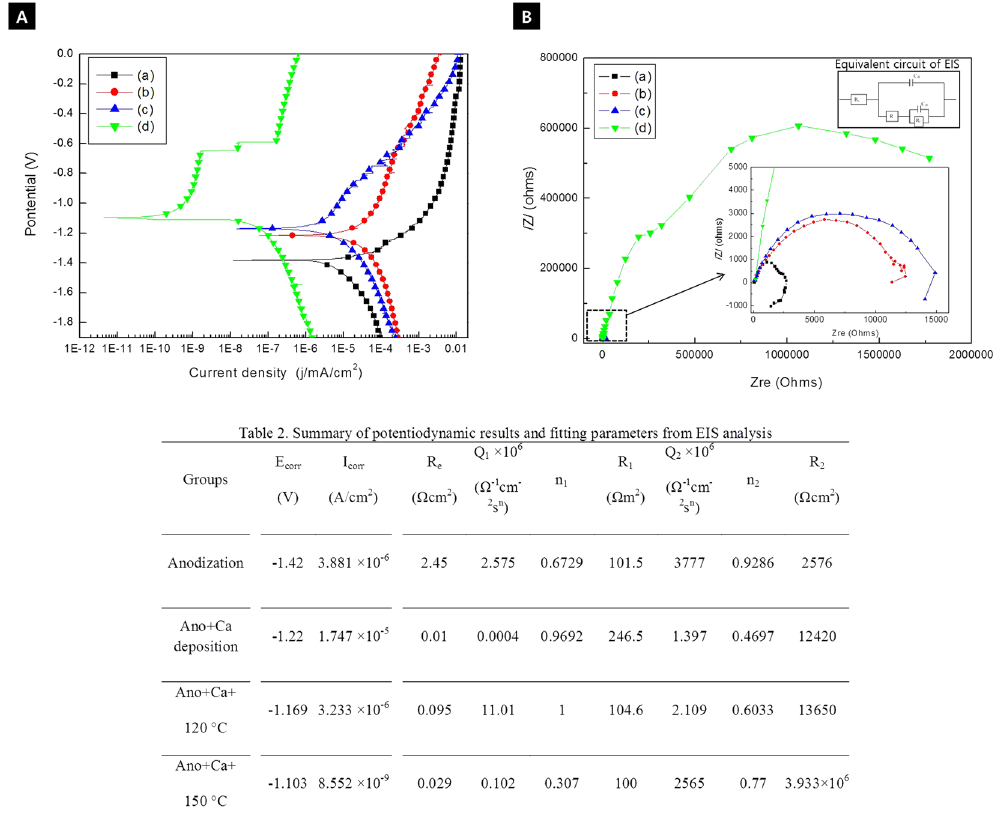
Figure 4. Potentiodynamic polarization curves ( A ) and Nyquist plots from EIS ( B ) as determined of Mg-3Al- 1Zn-1.5Ca alloy (a) after anodization, (b) Ca deposition post anodizing, (c) hydrothermal treatment at 120 °C, and (d) hydrothermal treatment at 150 °C, and summary of potentiodynamic and fitting parameter from EIS test ( C ).